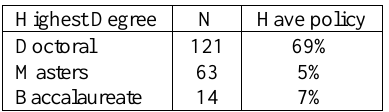
Table 2. Institution highest degrees granted and percent having a UAV policy (N=198).